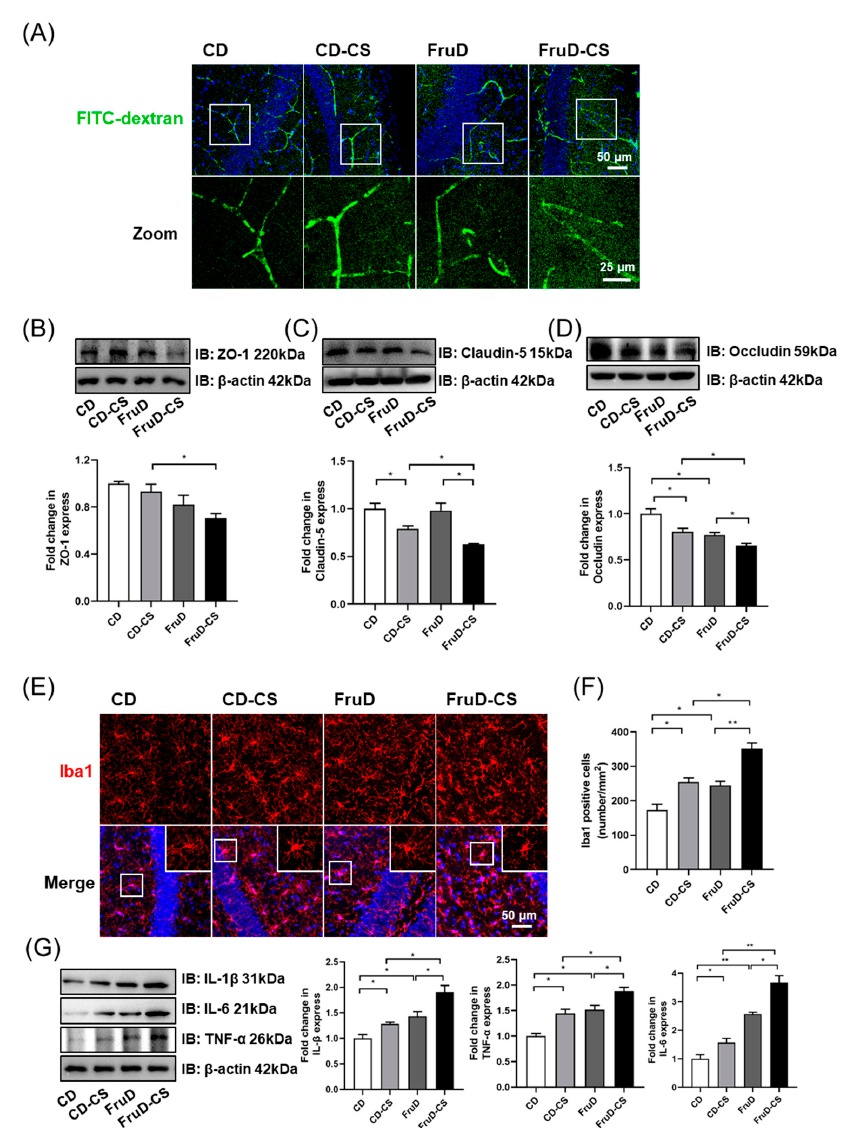
Figure 3. Chronic stress exacerbates the impaired BBB integrity and activates microglia in FruD mice. ( A ) Representative confocal images for brain vessel visualization in mice injected with FITC-dextran. ( B – D ) Representative immunoblot and quantification of ZO-1 ( B ), claudin-5 ( C ) and occludin ( D ) protein levels in the brain vessel. ( E ) Representative confocal images labeled with Iba1. ( F ) Number of Iba1 positive microglia was quantified. ( G ) Representative immunoblot and quantification of IL-1 β , IL-6 and TNF- α protein levels in the hippocampus. Data are expressed as mean ± SEM, * p < 0.05, ** p < 0.01.